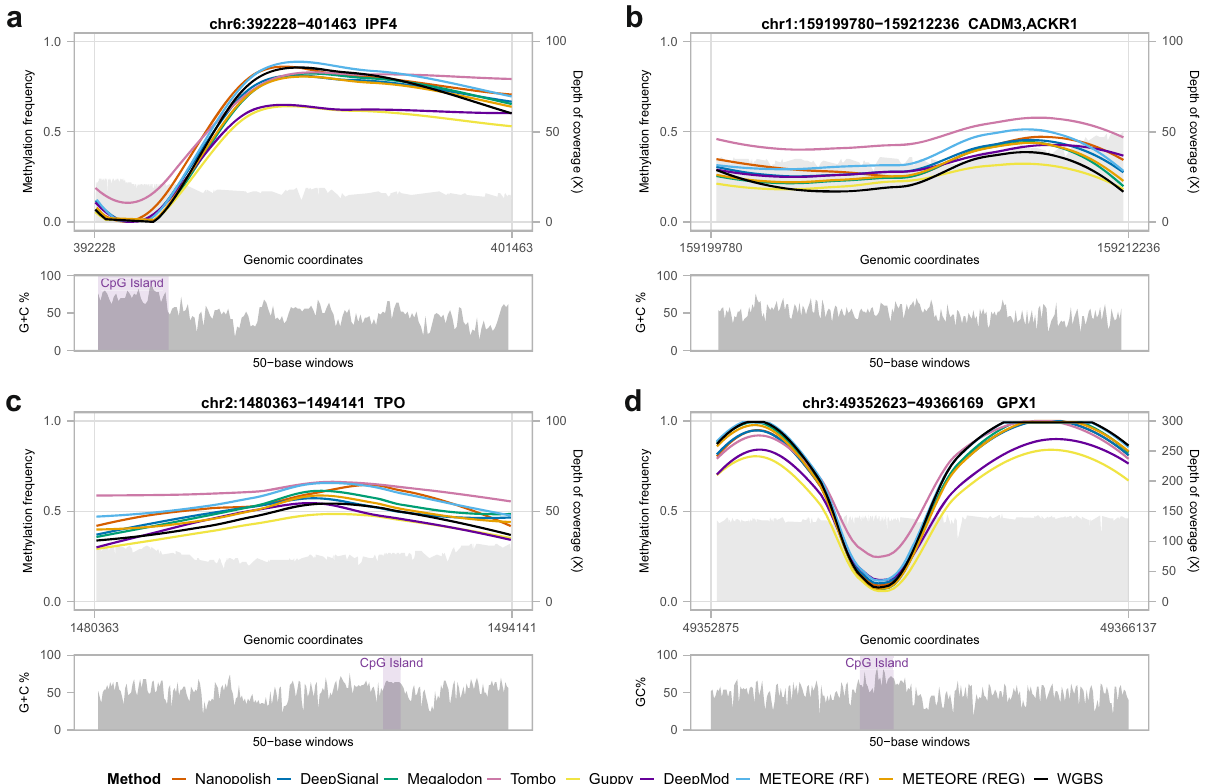
Fig. 5 Comparison of CpG methylation predictions from nanopore with whole-genome bisul fi te sequencing (WGBS) along Cas9-targeted regions. Locally estimated scatterplot smoothing (LOESS) line plots of methylation calls frequency predictions (left y axes) from WGBS Illumina and from nanopore data using seven tools: Nanopolish, DeepSignal, Megalodon, Tombo, Guppy, DeepMod, and METEORE random forest (RF) and regression (REG) models. The plots include the nanopore read coverage (right y axes), shown as a light gray area. The panels below show the GC content of the region, using a window size of 50 bases. a – c Three of our ten target regions and d one of the eight target regions from Gilpatrick et al. 18 . The depicted regions are a chr6:392228-401463, which covers the fi rst and second introns of gene IRF4 ; b chr1:159199780-159212236, which covers the genes ACKR1 and CADM3; c chr2:1480363-1494141, which covers the gene TPO ; and d chr3:49352525-49366169, which covers the genes GPX1 . A zoom in of the LOESS line plots with the individual methylation calls and logos for the sequence context around the CpG site in four CpG islands (CGIs) of our target regions are shown in Supplementary Fig.